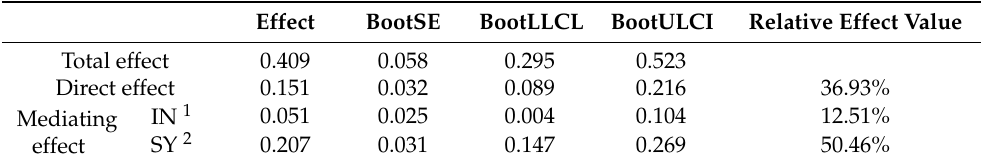
Table 6. The total effect, direct effect, and mediating effect of positive message